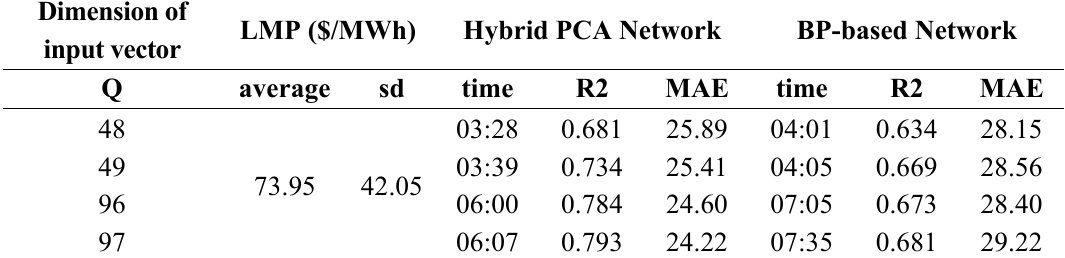
Table 5. Performance comparison between the proposed hybrid PCA and BP-based neural network (Byberry,